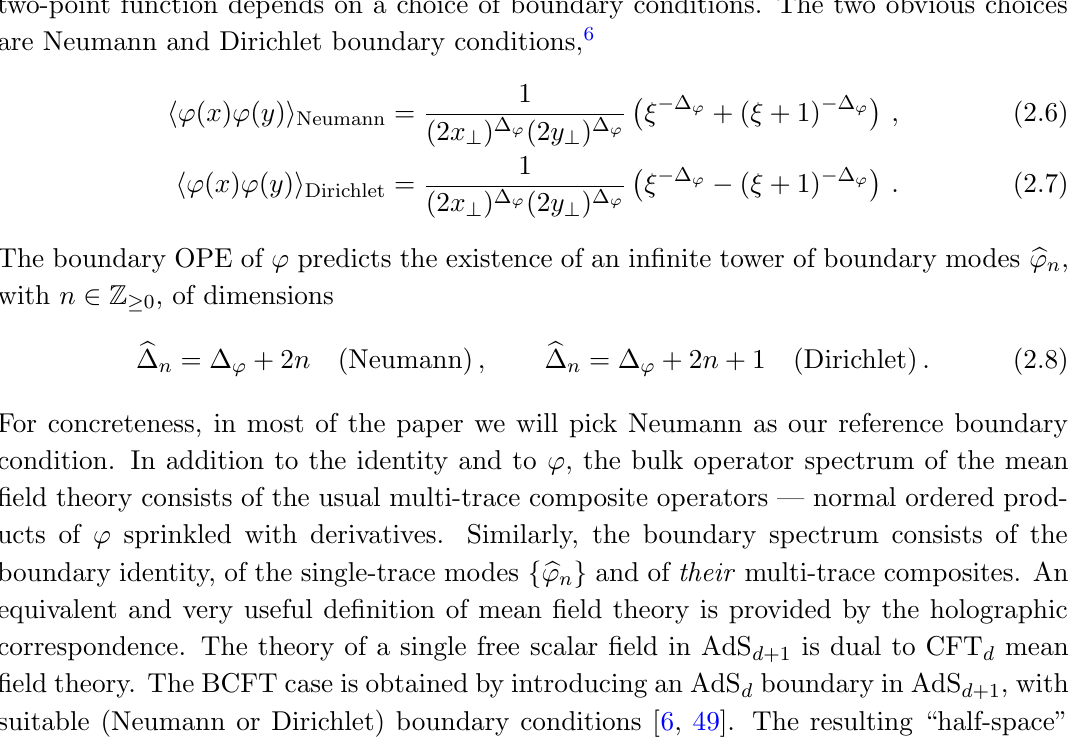
O 2 . Right: to reach the Regge limit, we should O 1 1. In doing so, ! (cid:0)